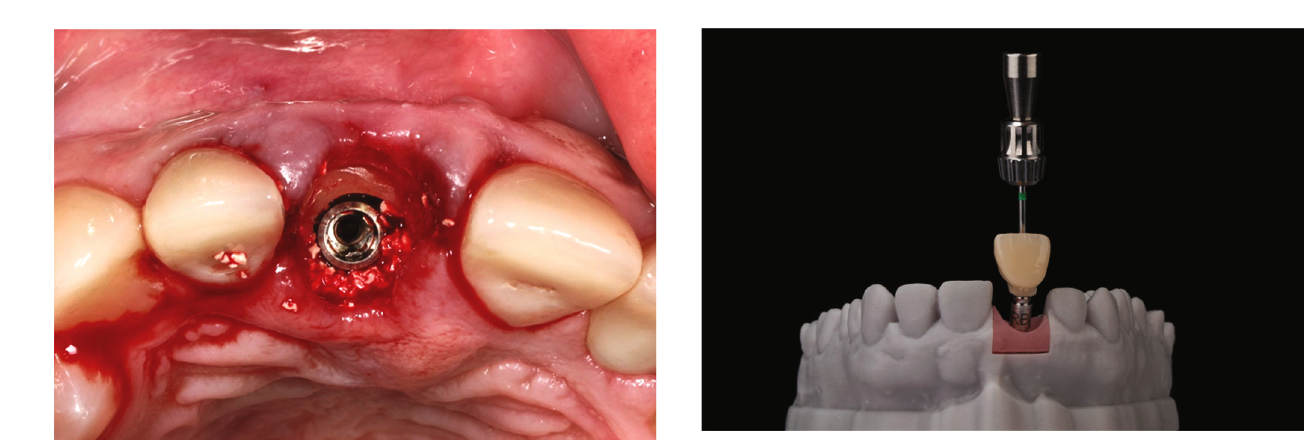
Figure 8: The occlusal view through stent.